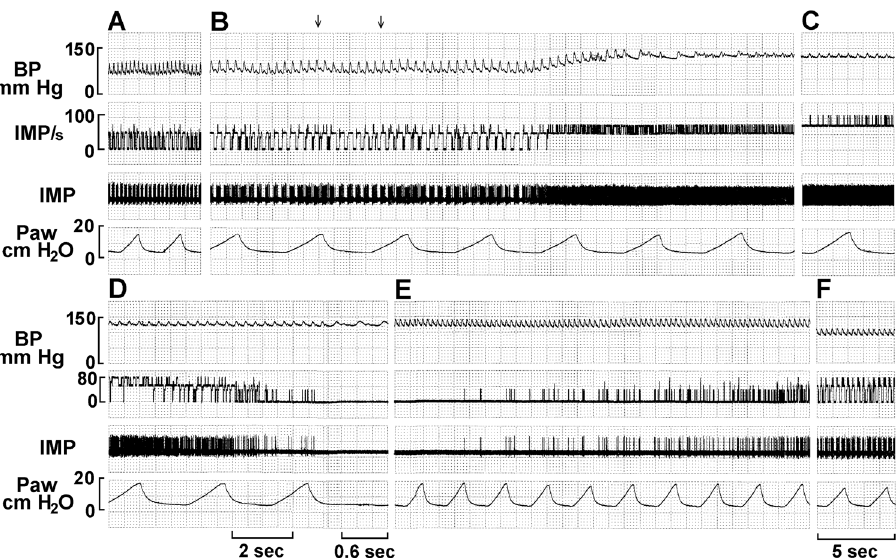
Figure 7. Typical baroreceptor unit response recorded in the left depressor nerve of an anesthetized, open-chest and mechanically ventilated rabbit. Traces are: BP, arterial blood pressure; IMP/s, unit activity, impulses counted at a bin width of 0.05 s; IMP, unit activity; Paw, airway pressure. A, control; B, unit response to intravenous injection of phenylephrine (10 mM, 0.2 ml, indicated by the two arrows on top of the BP trace). Time periods between B–C, C–D, and D–E were 40, 10, and 30 s, and between E–F was 3 min. Please note that the unit discharges at very high frequencies as the BP is maintained at a high level (C); unit activity became irregular before inactivating (D). Please also note that A, E, and F have the same paper speed, so do B, C and D.